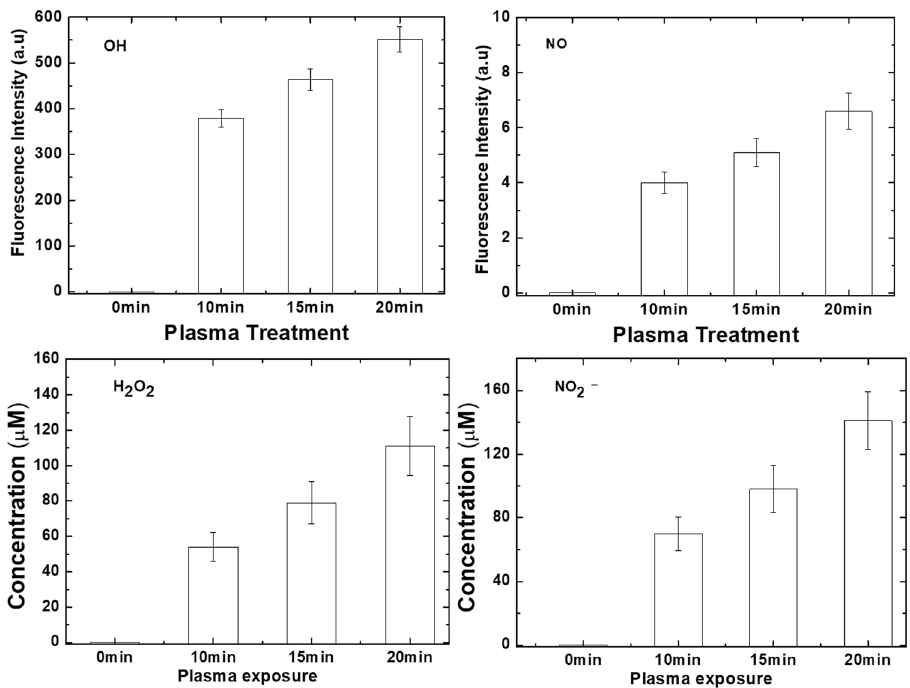
Figure 1. Fluorescence intensities or concentrations of different RONS generated during DBD treatment for 0, 10, 15 and 20 mins.